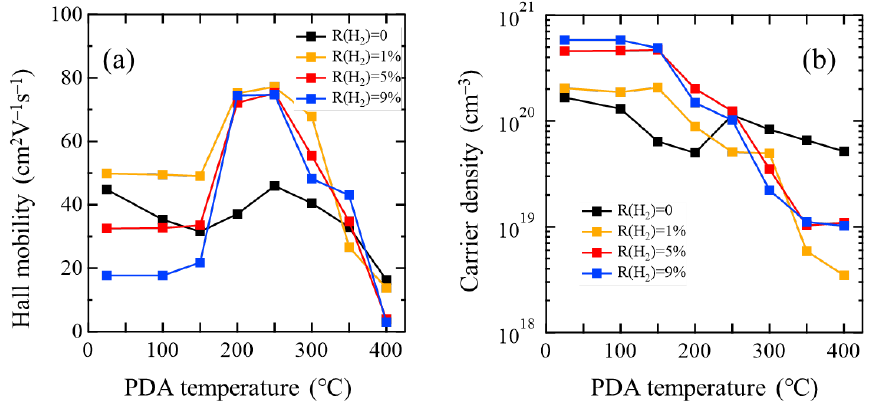
Figure 4. ( a ) Hall mobility and ( b ) carrier density of InO x [R(H 2 ) = 0] and InO x :H [R(H 2 ) = 1, 5, and 9%] films as a function of PDA (in N 2 ) temperature.